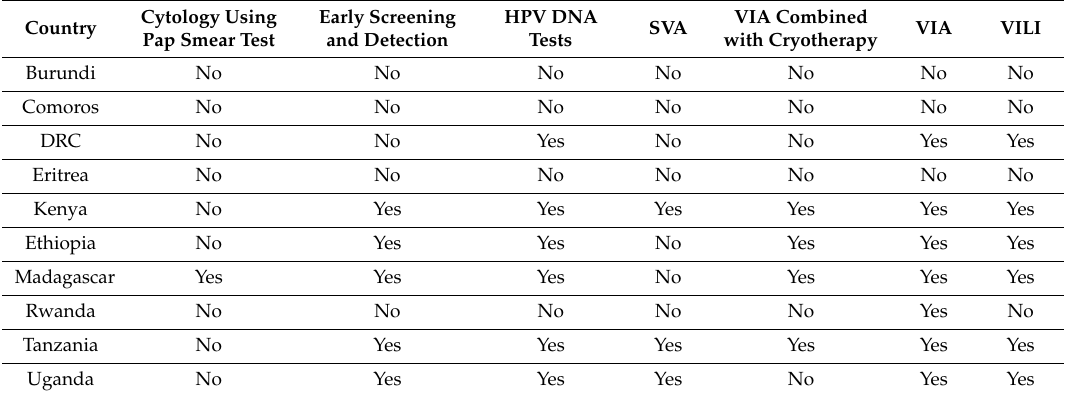
Table 3. Coding presence for the di ff erent modalities of screening among the East African countries. Cytology Using Country Pap Smear